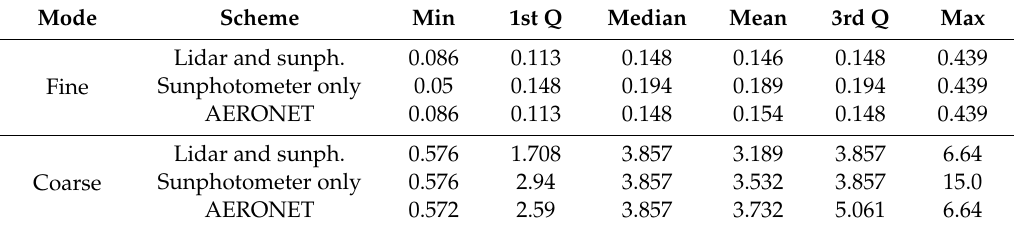
Table 1. Statistical values of radius for the fine and coarse modes of the di ff erent schemes.